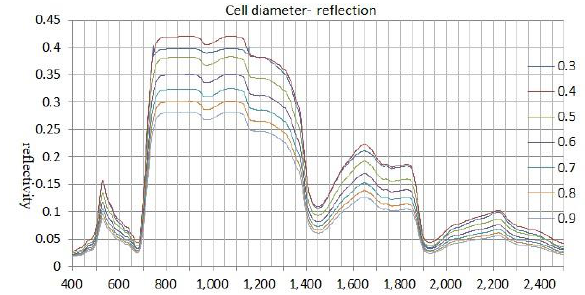
Figure 4. Reflectivity change curve of cell diameter The cell diameter- reflectivity change curve shows that when the cell diamter increase gradually, the reflectivity of leavse in the short-wave infrared band decreses gradually; when other parameters are fixed, the cell dimension affects the distribution structure of leaf internal cells and causes the change of reflcivity in the near infrared part; meantime, the cell fluid in cells is the main water storage structure of leaves. The change in the curve also shows that the change of cell diamter affects the reflectivity of short-wave infrared part, especially the three absorption vallyes under the effect of water. The analysis shows that the lager the cell dimater, the more the water content, so the water absorption vally decreases. This process reflects the effect on leaf spectrum in the short-wave infrared part from water content from the respective of cell diameter